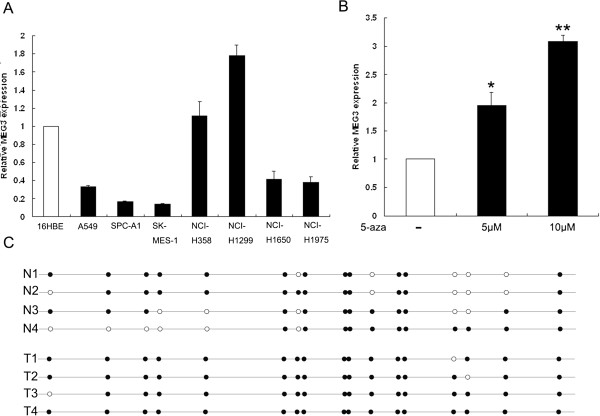
Analysis of the correlation between methylation status and expression of MEG3. (A) Analysis of MEG3 expression levels in NSCLC cell lines (A549, SPC-A1, NCI-H1650, NCI-H1299, NCI-358, NCI-H1975 and SK-MES-1) compared with the normal bronchial epithelial cell line (16HBE) by qRT-PCR. (B) The level of MEG3 expression in SPC-A1 cells following 5-aza-dC (0, 5, 10 μM) treatment. (C) The methylation status of the CpG island of MEG3 was assessed by bisulfite sequencing in NSCLC and normal tissues. Open and filled squares denote unmethylated and methylated CpG sites, respectively. Each row represents a single clone. *P < 0.05; **P < 0.01.